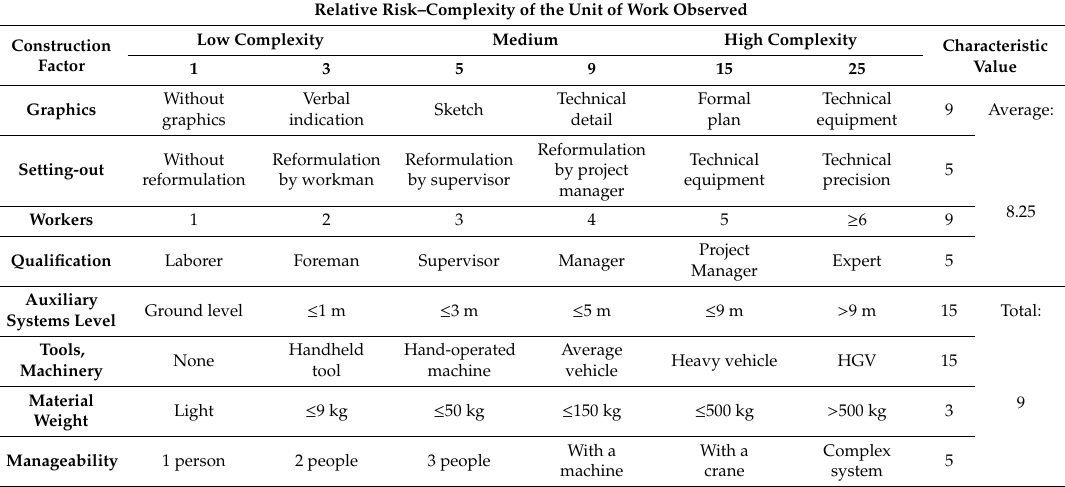
Table 4. Example of characteristic value in relative